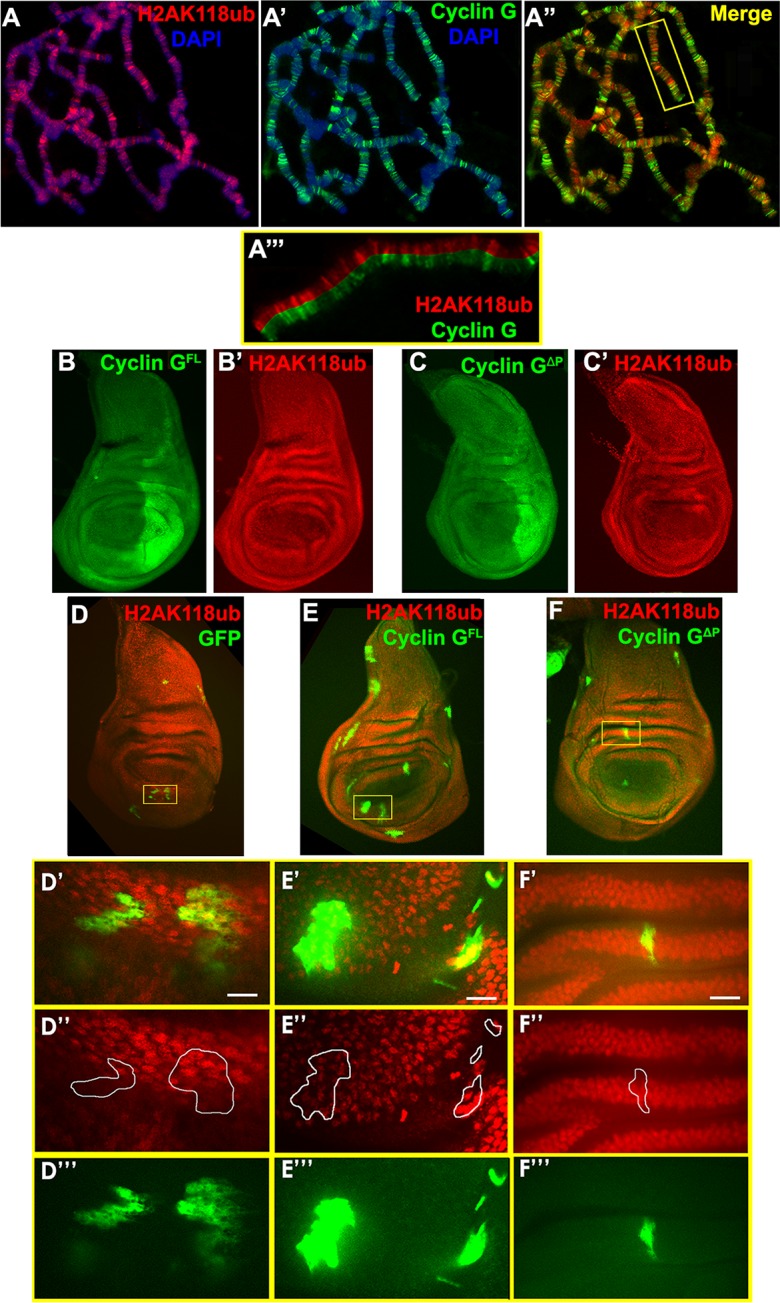
Cyclin G co-localizes with H2AK118ub at many sites on polytene
chromosomes but overexpression of CycG does not modify
global H2AK118ub.A, A’, A”–Immunostaining of polytene chromosomes from
w1118 third instar
larvae. H2AK118ub (red), Cyclin G (green), DAPI (blue).
A”‘–Close-up of the box showed in A”. B,
B’–Wing imaginal discs of 3rd instar larvae expressing
CycGΔP in the posterior
compartment under control of the en-Gal4 driver,
stained with anti-Cyclin G (green) and anti-H2AK118ub (red). C,
C’–Wing imaginal discs of 3rd instar larvae
expressing CycGΔEΔP in the
posterior compartment under control of the en-Gal4
driver, stained with anti-Cyclin G (green) and anti-H2AK118ub (red).
D, D’, D”, D”’–GFP clones in wing imaginal discs
stained with anti-H2AK118ub (red). D’, D” and D”’ are close-up views of
the yellow rectangle shown in D. E, E’, E”,
E”’–CycGΔP
clones marked by GFP in wing imaginal discs stained with anti-H2AK118ub
(red). E’, E” and E”’ are close-up views of the yellow rectangle shown
in E. F, F’, F”,
F”’–CycGΔEΔP
clones marked by GFP in wing imaginal discs stained with anti-H2AK118ub
(red). F’, F” and F”’ are close-up views of the yellow rectangle shown
in F. Scale bars: 50 μm.